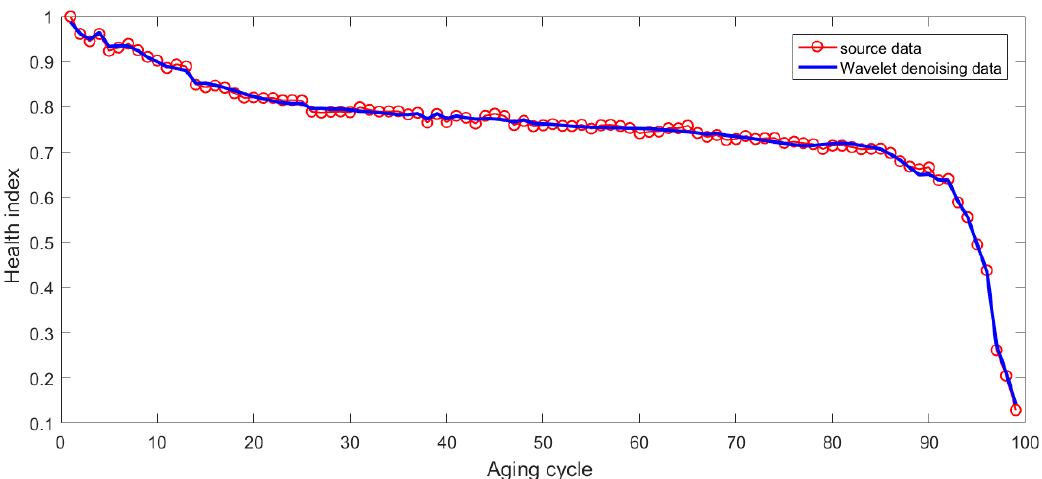
Figure 9. Degradation trend of health index of the electromagnetic coil after wavelet denoising.